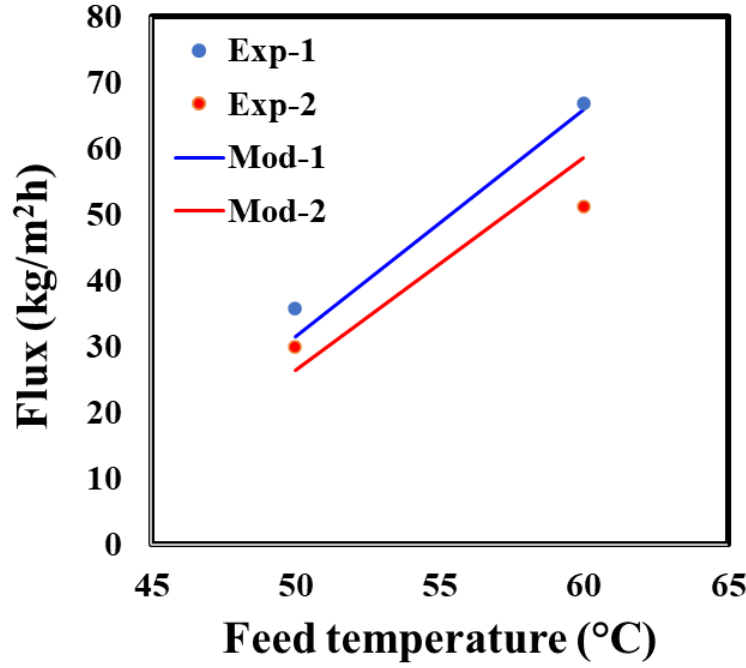
Figure A2. VMD model validation (experimental data can be retrieved from [16]).